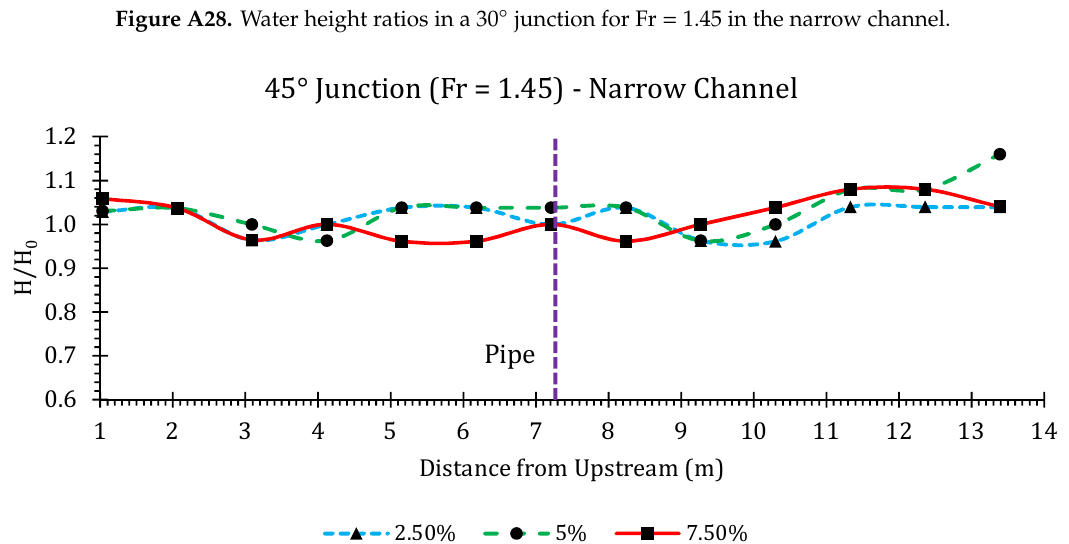
Figure A29. Water height ratios in a 45 ◦ junction for Fr = 1.45 in the narrow Figure A29. Water height ratios in a 45° junction for Fr = 1.45 in the narrow channel. Figure A29. Water height ratios in a 45° junction for Fr = 1.45 in the narrow channel. Figure A29. Water height ratios in a 45° junction for Fr = 1.45 in the narrow channel.